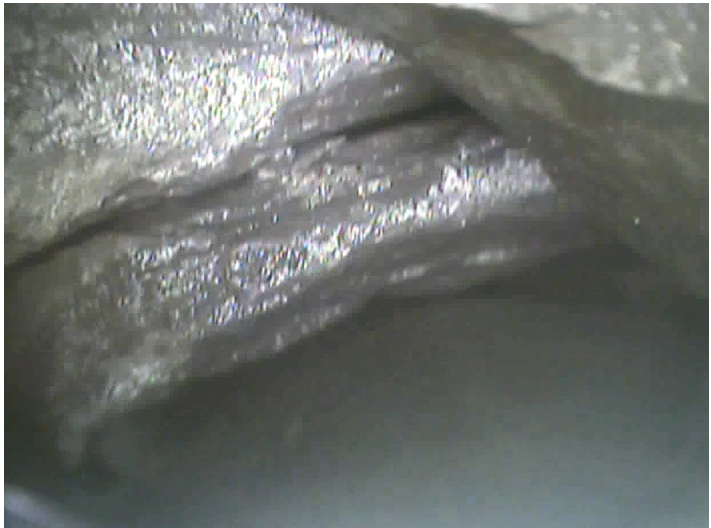
Figure 13. Observation in the 4 m diagonal borehole at a length of 3.5 m.